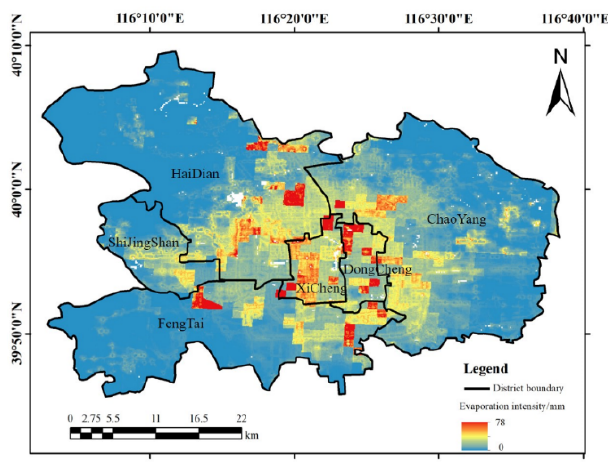
Figure 4. Distribution map of human body perspiration intensity in six core districts of Beijing.